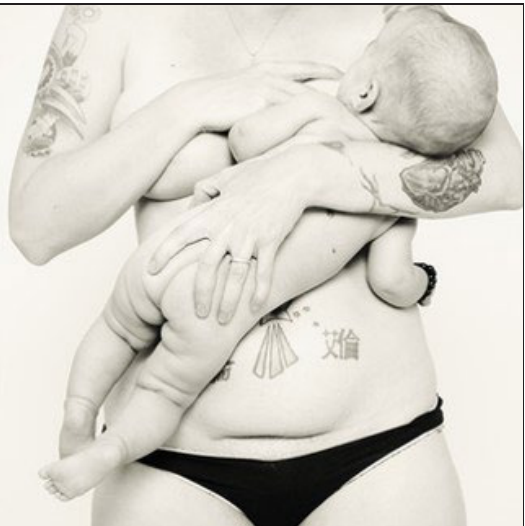
Figure1: Ashlee Wells Jackson, 4th Trimester Bodies Project inaugural photograph,